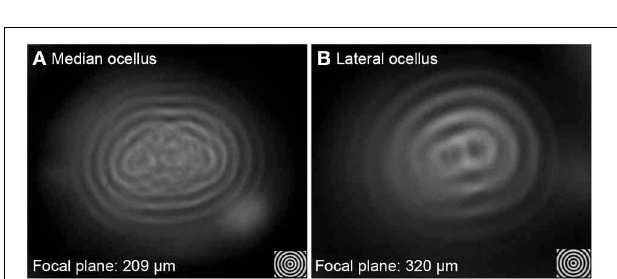
head. To the left the ocelli are dorsal. To the extreme right, the head has been rolled downwards by 90 ◦ to reveal all three ocellar regions (only the left ocellar retinas are present). (C) A lateral view of the lateral ocellus: only the dorsal retina can be observed. (F) A dorsal view of the three ocelli: only the ventral retina can be observed. Abbreviations: A, anterior; D, dorsal; L, lateral; LO, lateral ocellus; MO, median ocellus.